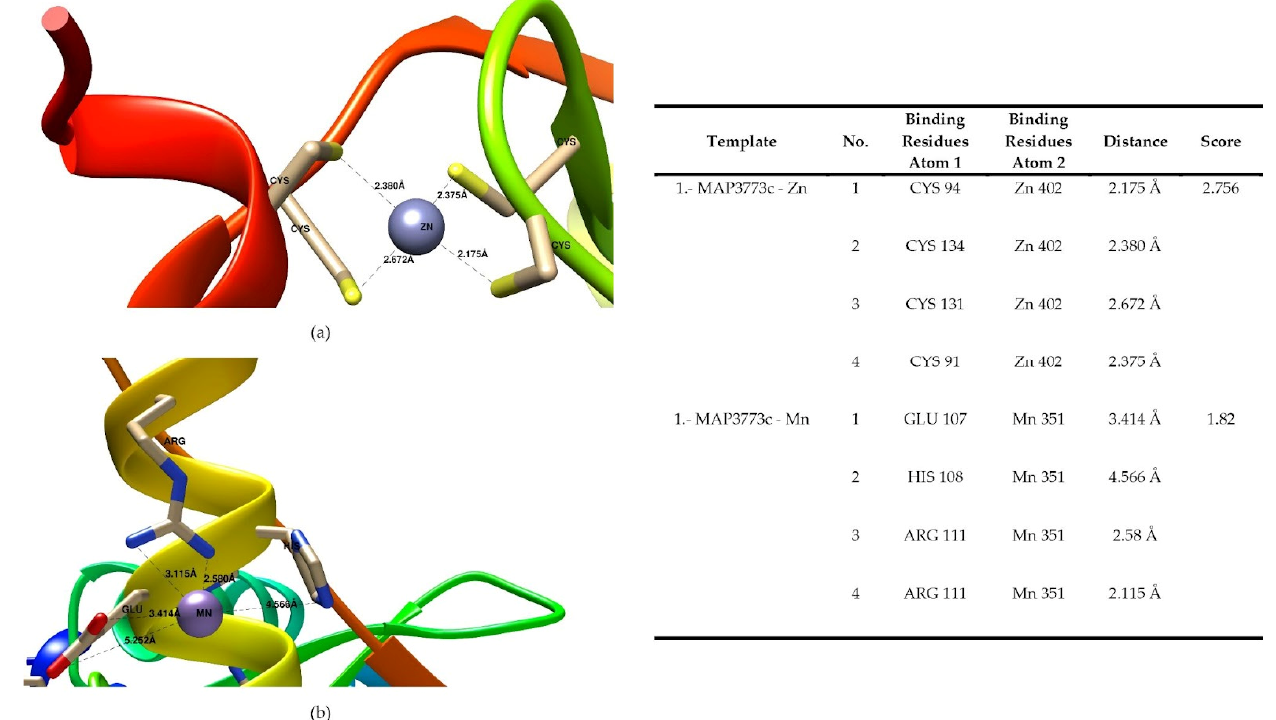
Figure 3. Docking presentation of the binding sites for metal ions (Mn 2+ and Zn 2+ ) in MAP3773c. Template of the MAP3773c model with ( a ) the Zn 2+ ion. ( b ) with Mn 2+ .